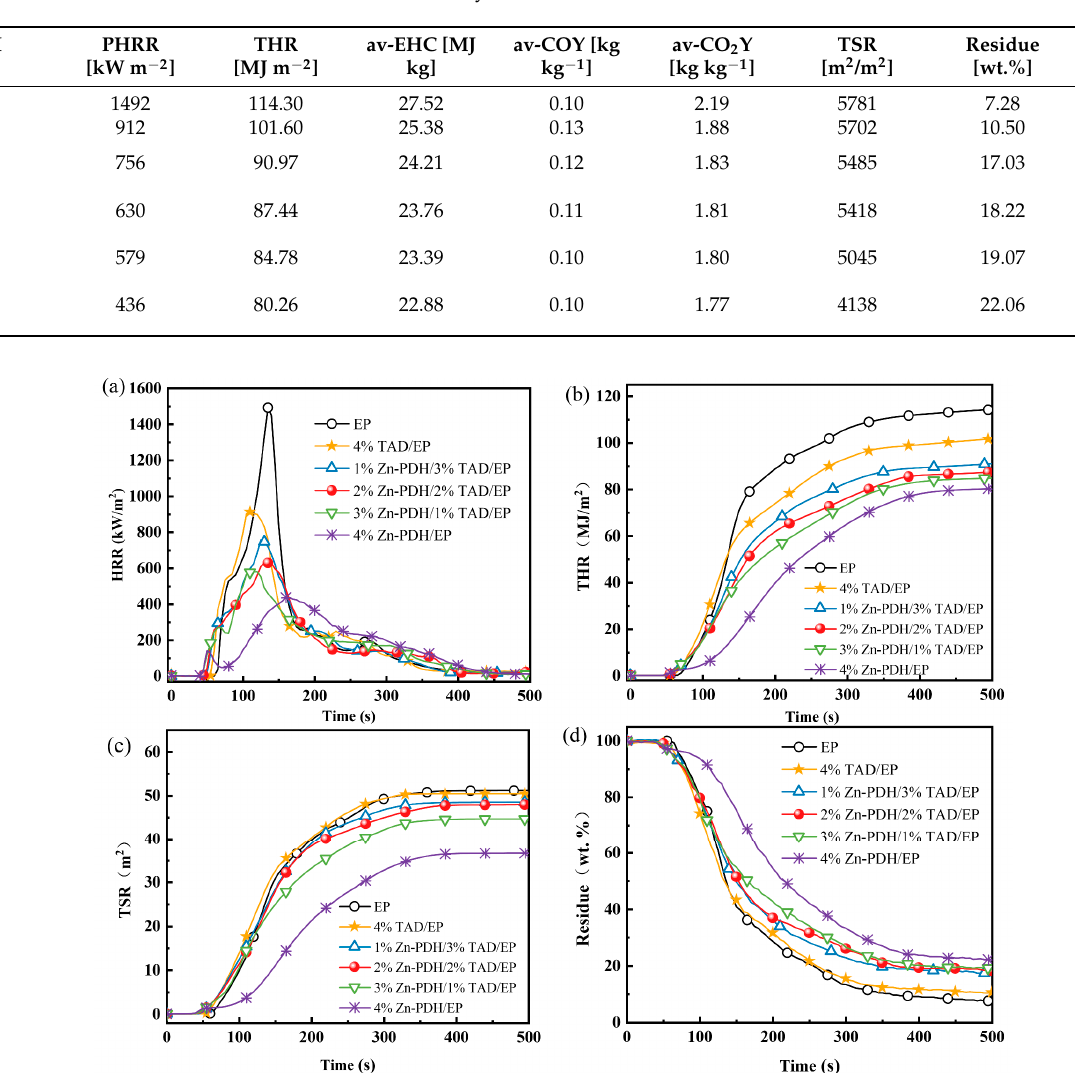
Table 4. Parameters of cone calorimetry test.